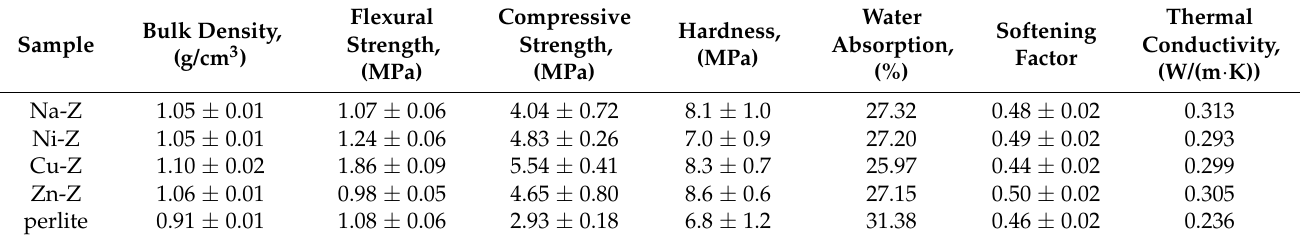
Table 2. Physical properties of gypsum